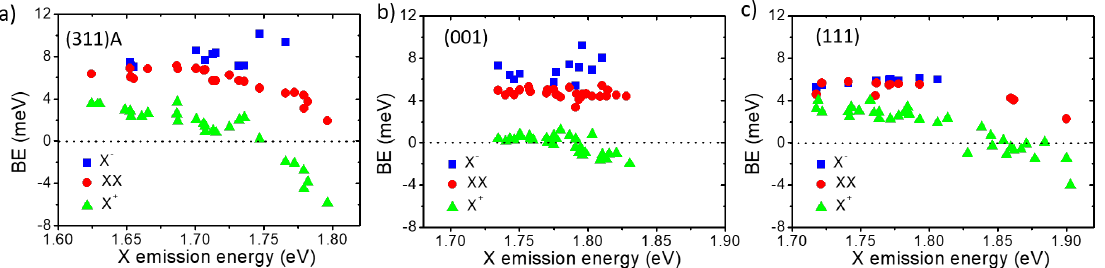
Figure 4. ( a ) Binding energy of XX, X + , and X − for (311)A QDs as a function of X emission energy, re-plotted from the reference [66] (311)A surface for the sample described in [69]. ( b ) Same as for (a) but for (001) QDs, re-plotted from reference [66] for the sample described in reference [71]. ( c ) Same as for (a) but for (111)A